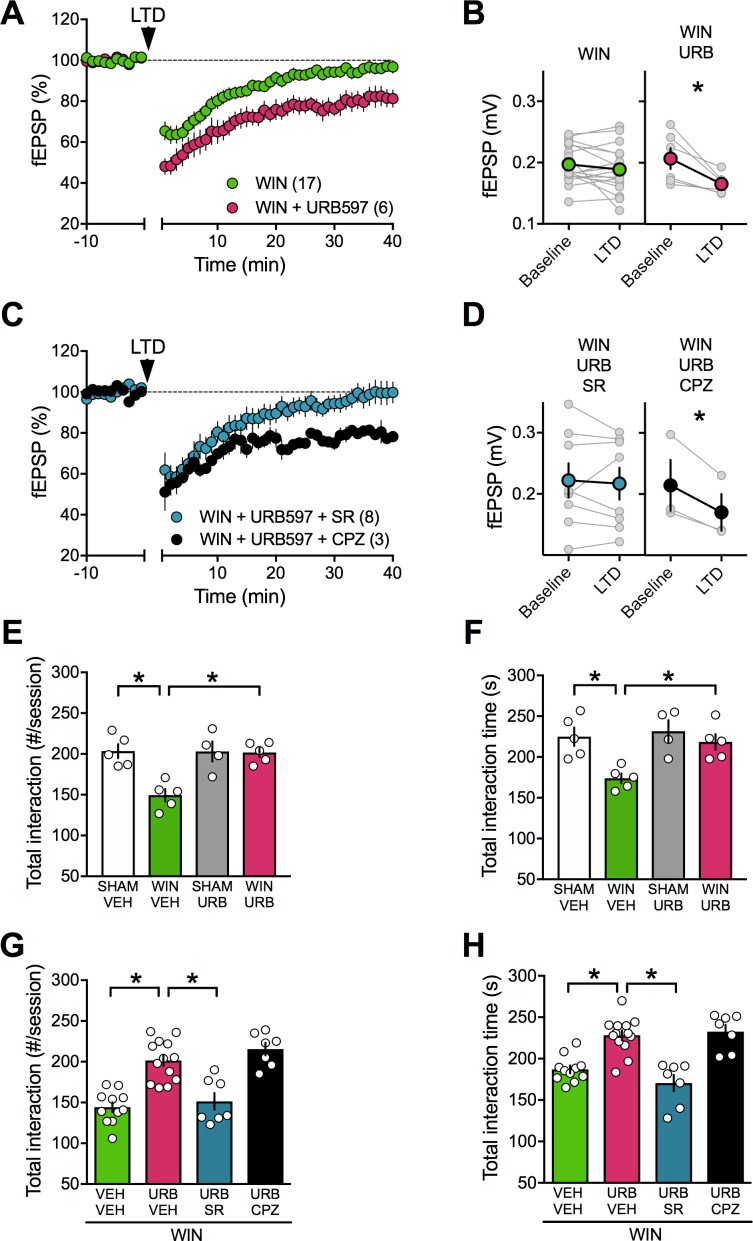
FAAH inhibition restores LTD and social interaction in male rats prenatally exposed to cannabinoids.(A) Average tie-courses of mean fEPSPs after 10 Hz LTD protocol (1à min, arrow) in WIN-exposed mPFC slices preincubated for 45 min in 2 μM URB597, a FAAH inhibitor. (B) Individual experiments (grey) and group averages (tan circles), before (baseline) and after (40 min) LTD induction showing that, in WIN-exposed male (WIN, n = 17, green circle), LTD is restored following bath-application of the FAAH inhibitor URB597 (2 μM, 45 min preincubation, URB, n = 6; pink circle): 0.207 ± 0.017 mV before and 0.165 ± 0.007 after LTD induction (n = 6; p<0.05, paired t-test). (C) The URB597 LTD rescue requires CB1R. Time course of fEPSP during 10 Hz stimulus evoked LTD (arrow, 10 min) in presence of CB1R antagonist SR141716 (SR, 4 μM, n = 8, blue circles) or TRPV1 antagonist Capsazepine (CPZ, 10 μM, n = 3, black circles) in WIN-prenatally exposed males. (D) Individual experiments: SR141716A preincubation prevented from the URB597 restoration of LTD: 0.222 ± 0.028 mV before and 0.217 ± 0.026 after LTD induction (blue circle, n = 8; p>0.05, paired t-test). In contrast, the TRPV1 antagonist did not prevent from URB597 rescue: 0.214 ± 0.042 mV before LTD and 0.170 ± 0.030 mV after LTD induction (black circle, n = 3; p<0.05, paired t-test). (E–F) Systemic administration of URB597 (0.1 mg/kg, i.p.) normalized the altered social behavior in male rats prenatally exposed to WIN (numbers of contacts: E: F(WIN in utero x URB)1,15=9.341. p<0.05, two-way ANOVA; time interaction: F: F(WIN in utero x URB)1,15=3.421, p=0.08, two-way ANOVA). (G-H) Pre-treatment with the CB1R antagonist SR141716A (1 mg/kg, i.p.) prevented the curating actions of URB597 (0.1 mg/kg, i.p.) on social interaction. In contrast, the TRPV1 antagonist capsazepine did not block the curating effects of URB597 on social interaction in adult rats prenatally exposed to WIN55,212–2 (number of contacts: G: F3,34=21.02, p<0.05, one-way ANOVA; time interaction: H: F3,34=18.34, p<0.05, one-way ANOVA). Scatter dot plot represents each animal. Error bars indicate SEM. *p<0.05 Student–Newman–Keuls test.